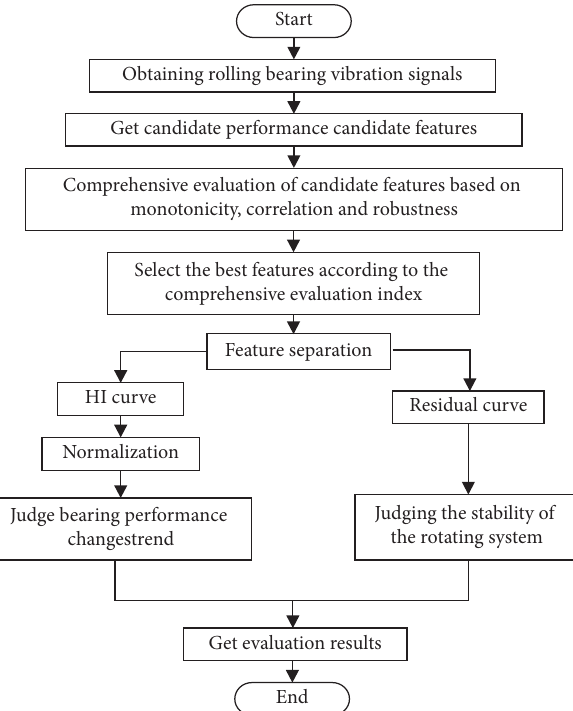
Figure 1: Performance degradation assessment